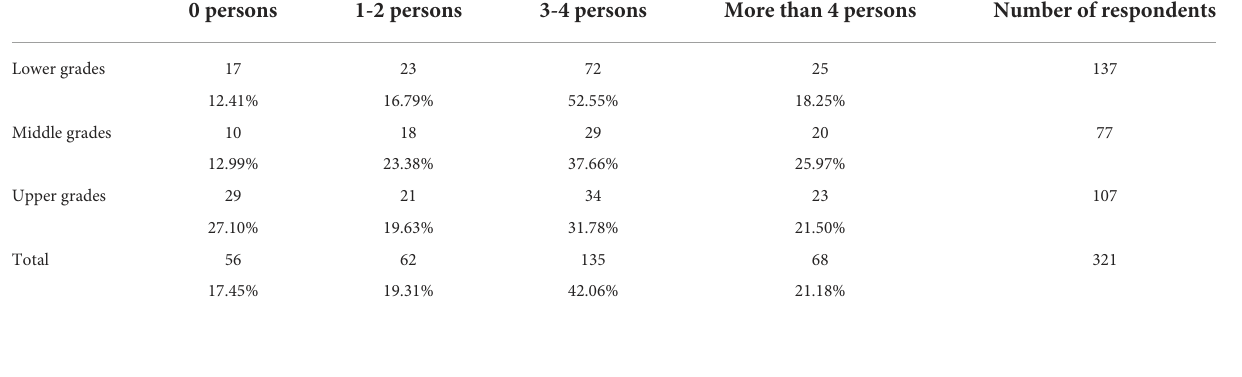
TABLE 4 Statistical analysis of persons in parent-child